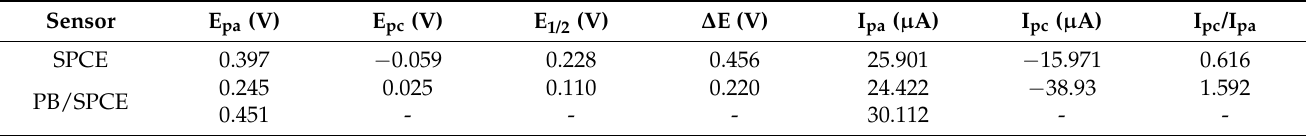
Table 2. Electrochemical parameters obtained from the cyclic voltammograms of the sensors immersed in K 4 [Fe(CN) 6 ] 10 − 3 M- KCl 10 − 1 M solution.